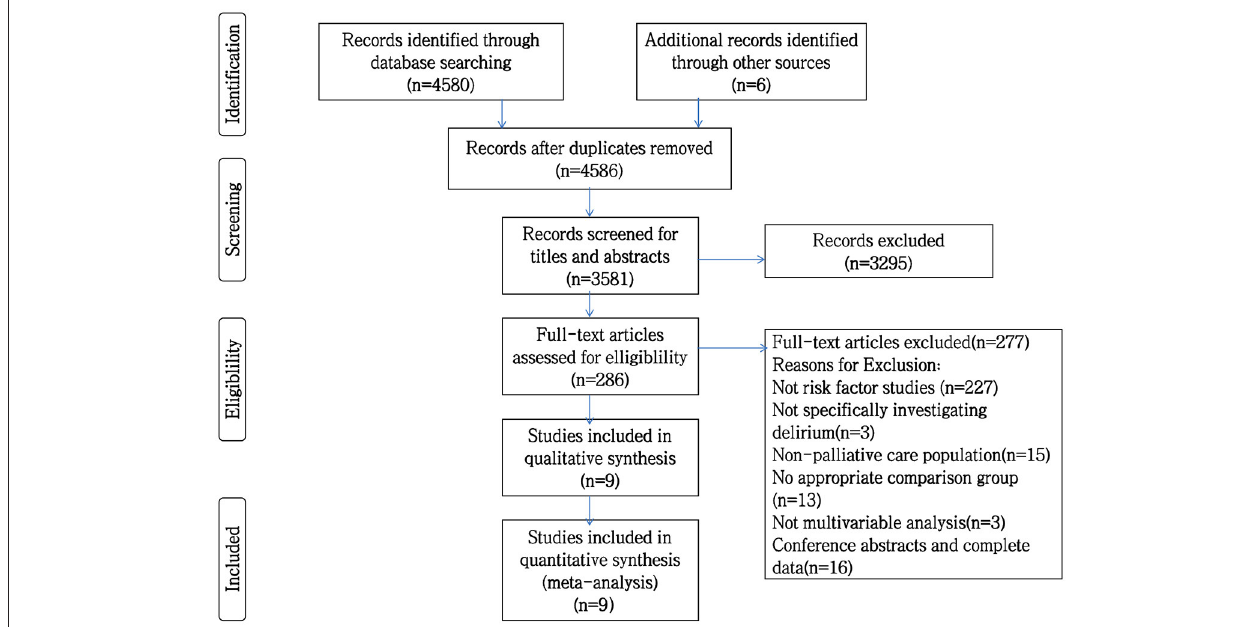
FIGURE 1 | PRISMA flowchart of studies included in systematic